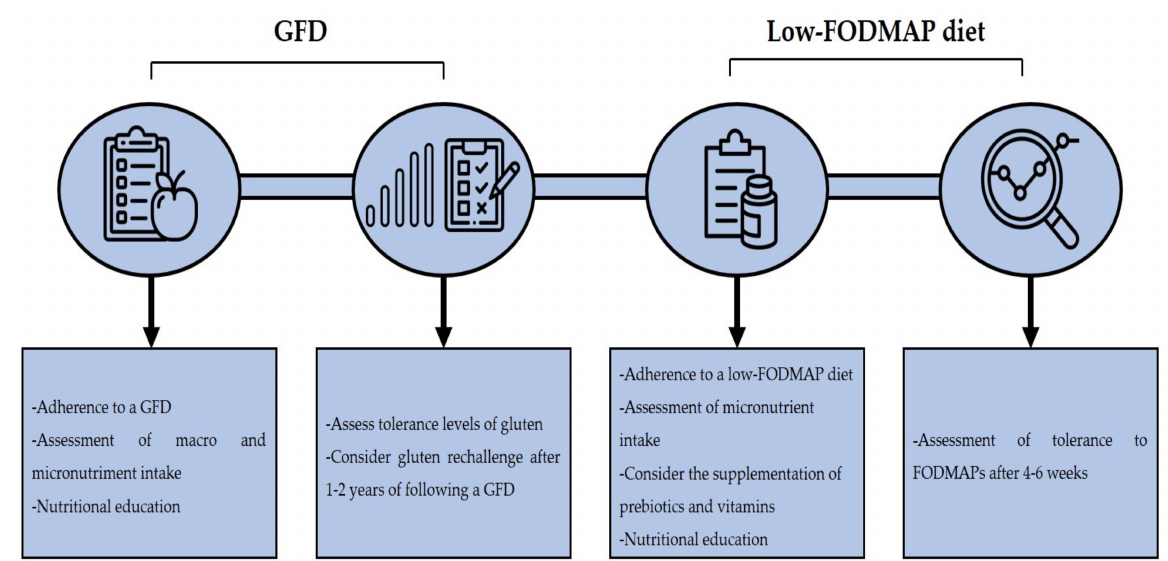
Figure 3. Dietary management in NCGS. Acronyms. GFD: gluten-free diet, FODMAP: fermentable oligo-, di-, monosaccha- rides, and